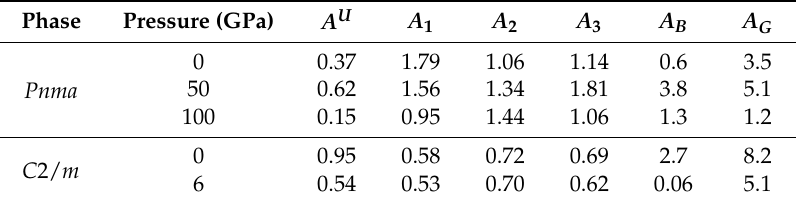
Table 4. Calculated universal elastic anisotropy index A U , shear anisotropic factors A 1 , A 2 and A 3 , and percentage of anisotropy in compressibility and shear A B and A G (in %) of Ca 2 C.